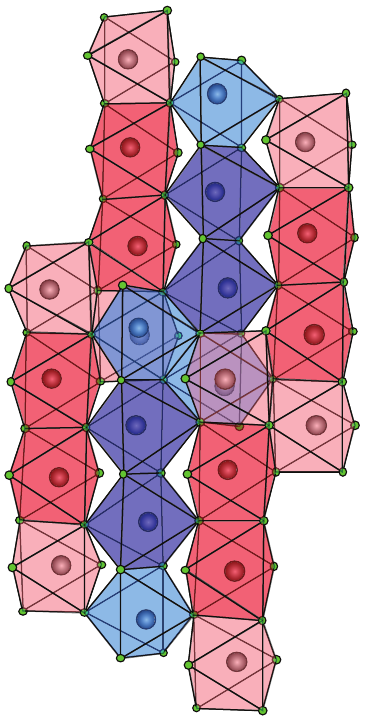
Figure 21: The low-temperature crystal structure of Ti 4 O 7 . Chains of four Ti sites run parallel to the pseudorutile c -axis. Red and blue (light and dark on the black and white image) chains of four Ti atoms correspond to the (a) and (b) chains of Ti atoms, respectively. Further gradation of red and blue on light and dark subsets indi- cates inequivalent Ti sites in (a) and (b)